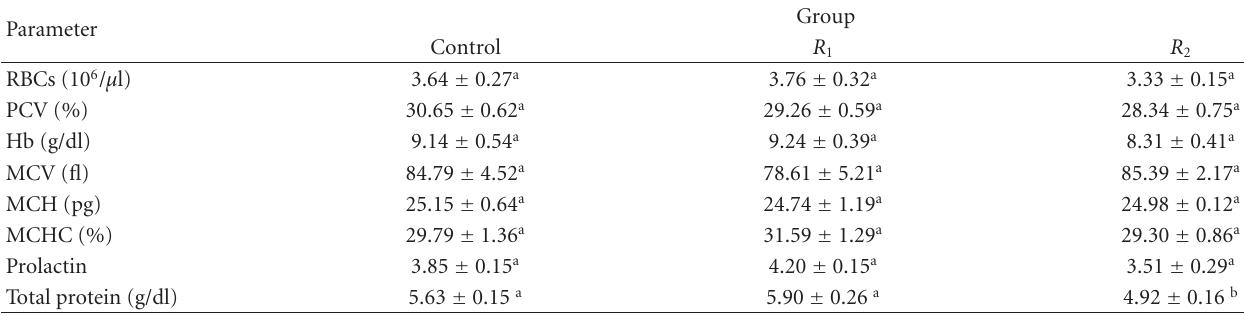
Table 3: The e ff ect of the stage of feed restriction during pregnancy on hematological findings of does at the 5th day post partum (means ±